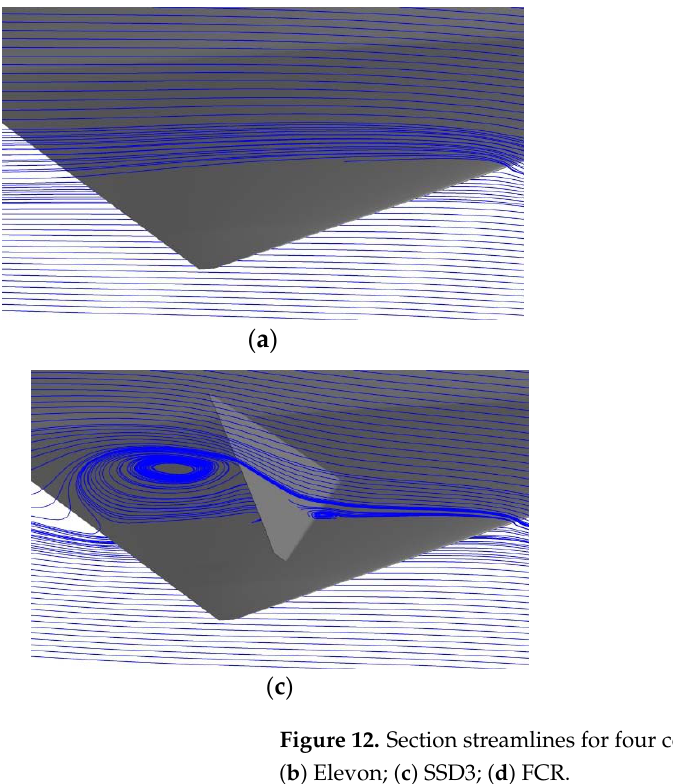
( b ) ( b ) Figure 14. Spatial streamlines around the SSD3 and the corresponding FCR, Ma = 0.2, Re = 3.98 × 10 7 , α = 6°: ( a ) SSD3; ( b ) The corresponding FCR. When the SSD unfolds upward by 45° alone, the windward area increases. The SSD resists the flow near the fore of the wing on the upper surface, the flow velocity decreases, the pressure increases, and the negative pressure value decreases. The closer it is to the SSD, the larger is the variation of the negative pressure on the upper surface, forming a large differential pressure drag, and the airflow fills from the edge of the SSD to its lee ‐ ward area to form a separation vortex. Owing to the influence of the separation vortex, the airflow on the lower surface of the wing washes up and accelerates, reducing the pres ‐ sure on the entire lower wing surface. The closer it is to the trailing edge, the more is the pressure reduction, and these flow phenomena show that when the SSD unfolds, the pres ‐ sure distribution changes complexly, resulting in a change in drag and lift; hence, the